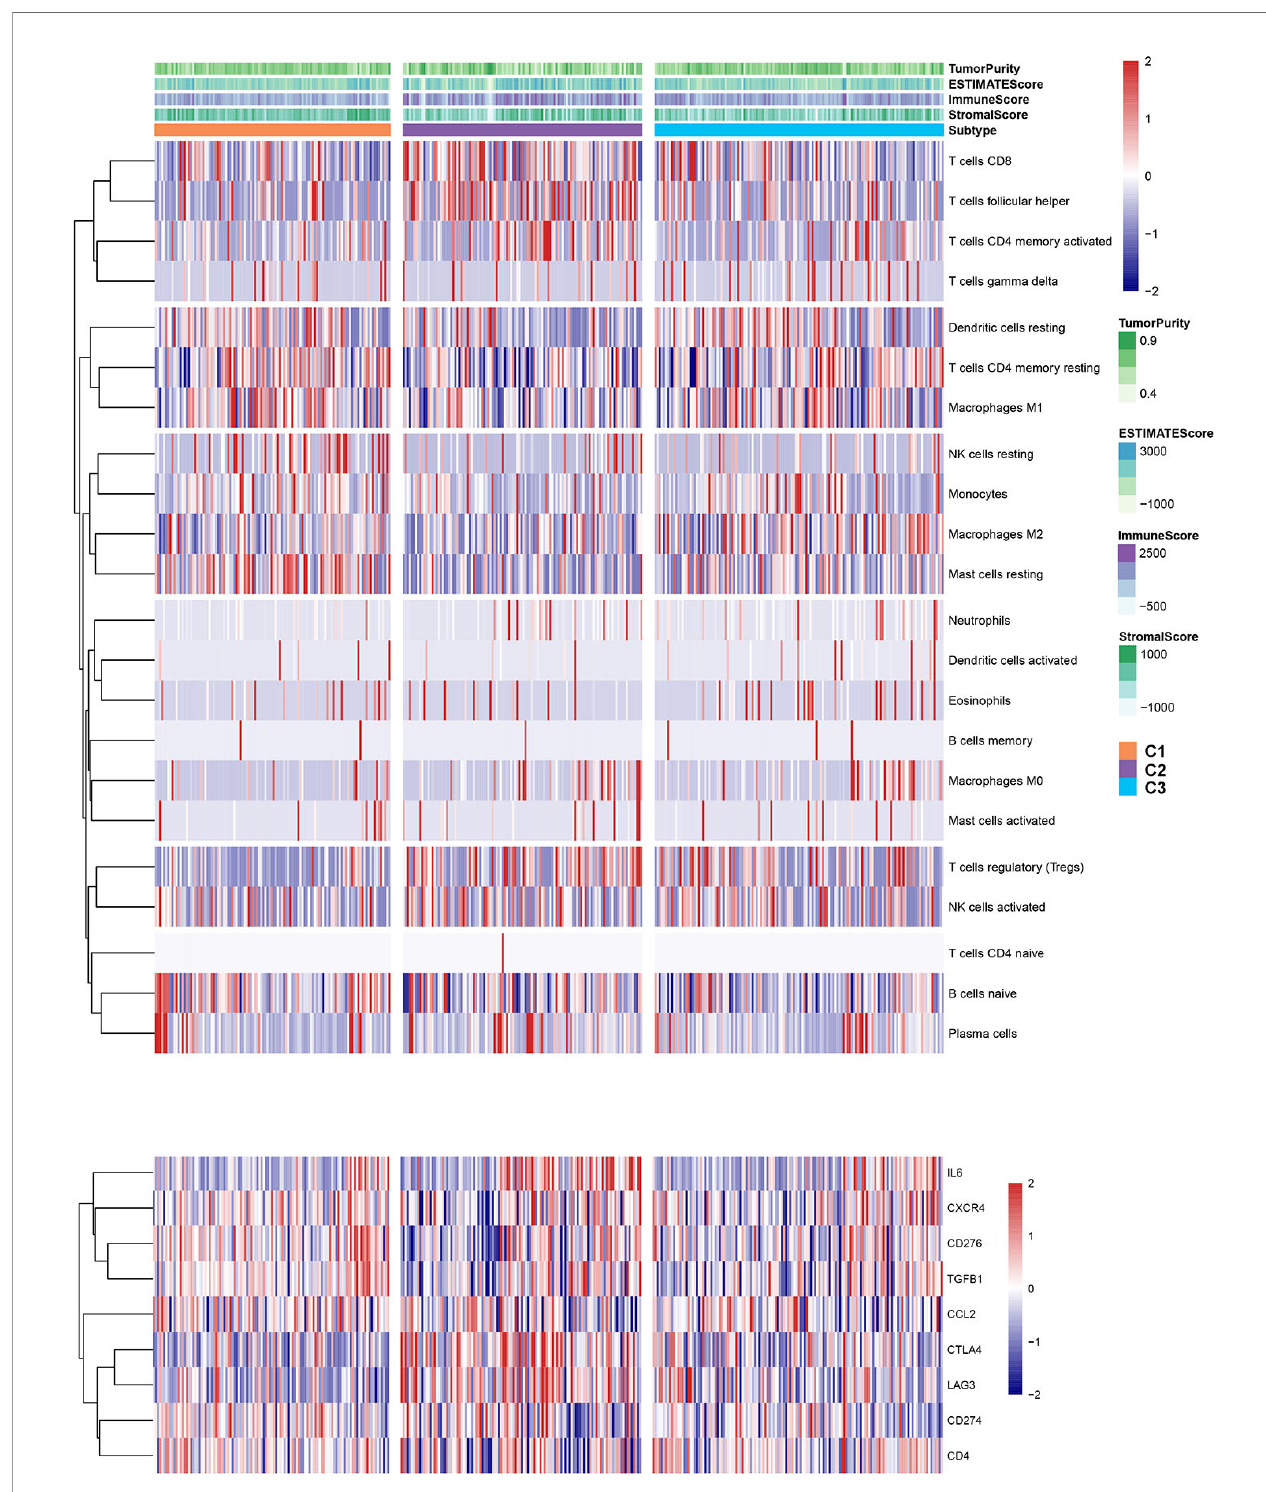
FIGURE 11 | The landscape of immune cell in fi ltration and immune check point in the three subtypes.